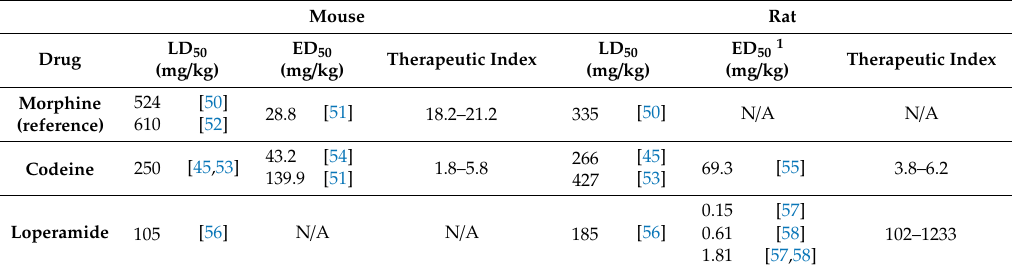
Table 2. E ffi cacy and toxicity of selected opioids in animal studies.